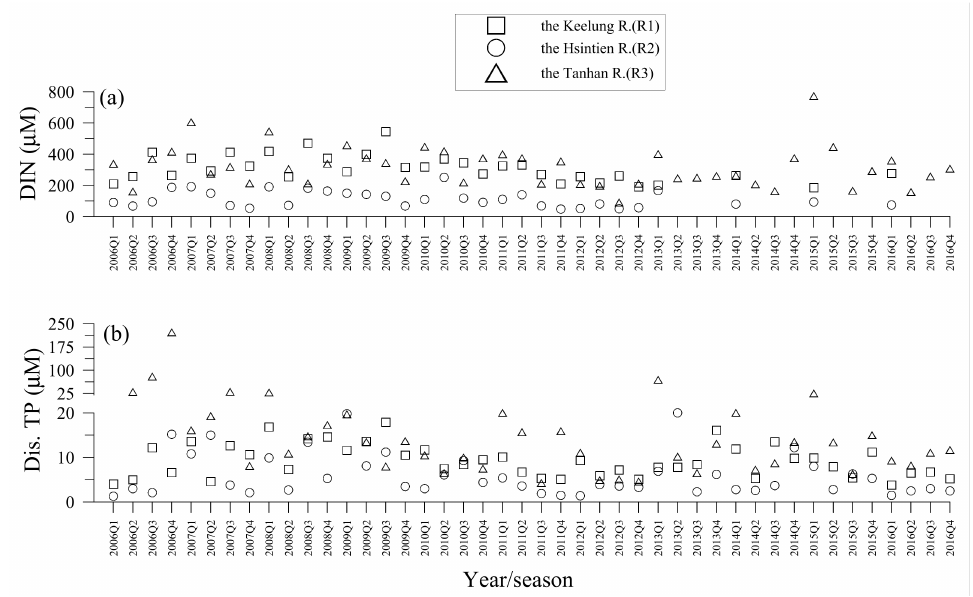
Figure 3. Seasonal concentrations of ( a ) DIN (ammonium + nitrite + nitrate) and ( b ) dissolved total